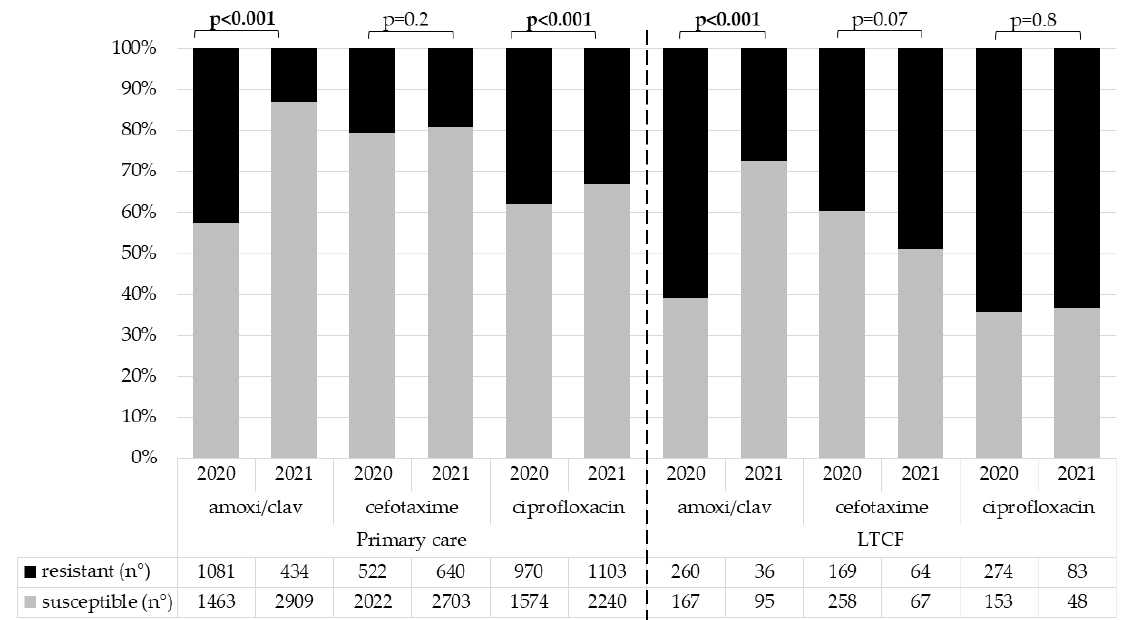
Figure 1. Comparison of antimicrobial susceptibility of Enterobacterales cultured from urine samples collected in the out-of-hospital setting during the first semester of 2020 and 2021.